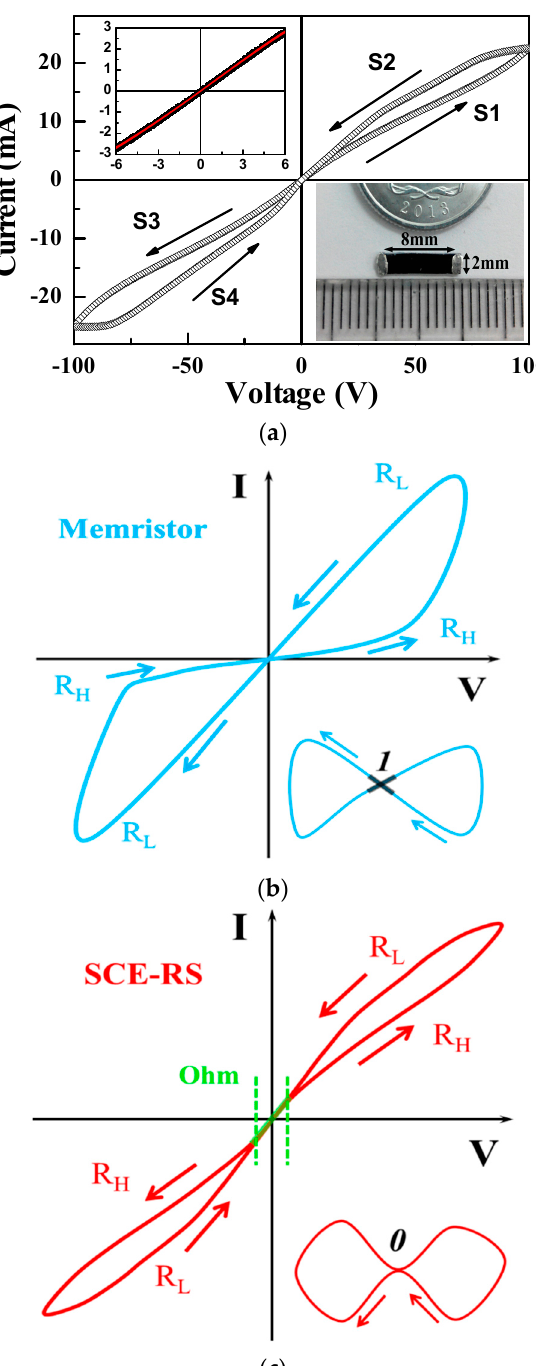
Figure 3. Space charge effect-resistance switching SCE–RS loops. ( a ) SCE–RS loop of device 1126-1# with L = 8 mm and sample width of 2 mm. The top left insert illustrates its enlarged plot between ± 6 V. The bottom right insert is the photo of In/n-Si/In device 1126-1#. ( b , c ) The schematic plots for SCE–RS and memristor respectively. R H and R L represent the high and low resistance states. The black arrows help to differentiate the direction of the applied voltage. Ohmic regime is emphasized in the SCE–RS loop between two green dash lines, while it does not exist in the memristor. The bottom right inserts in ( b , c ) illustrate the topology of the loops of SCE–RS and memristor